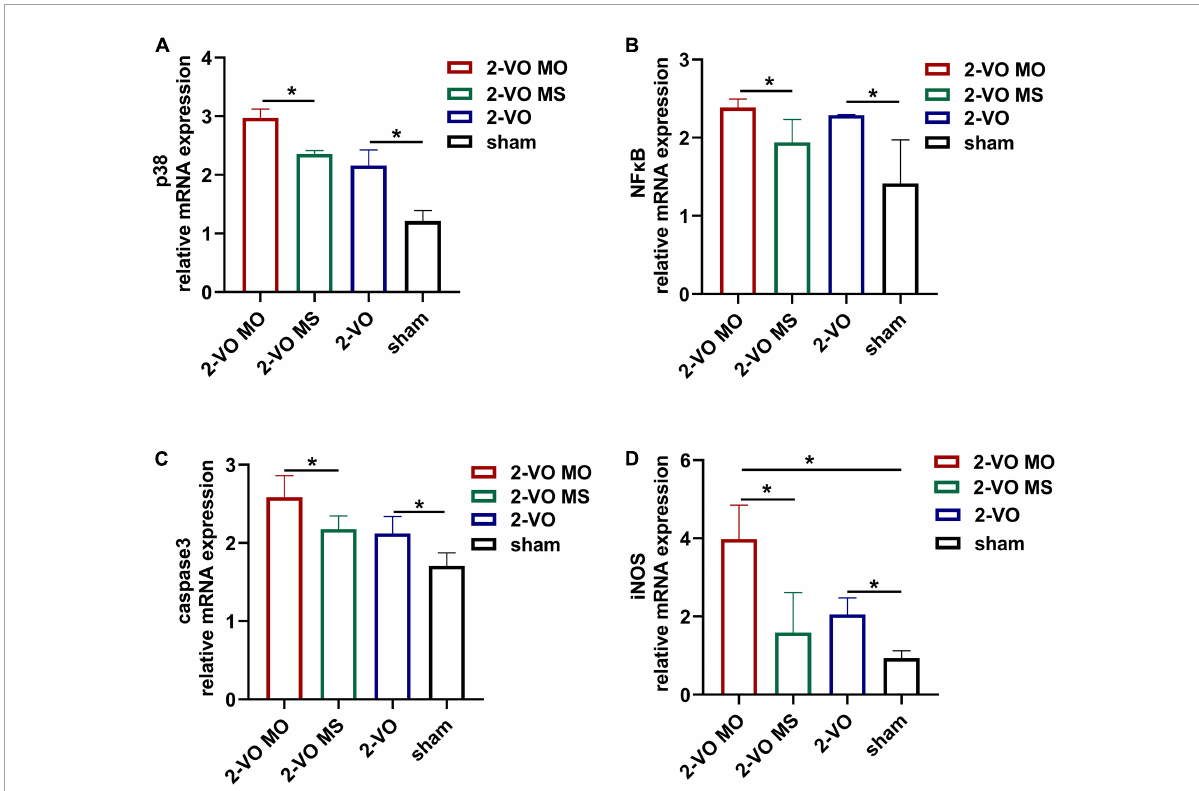
FIGURE5 Effects of molar loss on the mRNA expression of p38MAPK (A) , NF κ B (B) , caspase3 (C) , and iNOS (D) in the rat hippocampus. All values are expressed as mean ± SD, * p < 0.05, n =